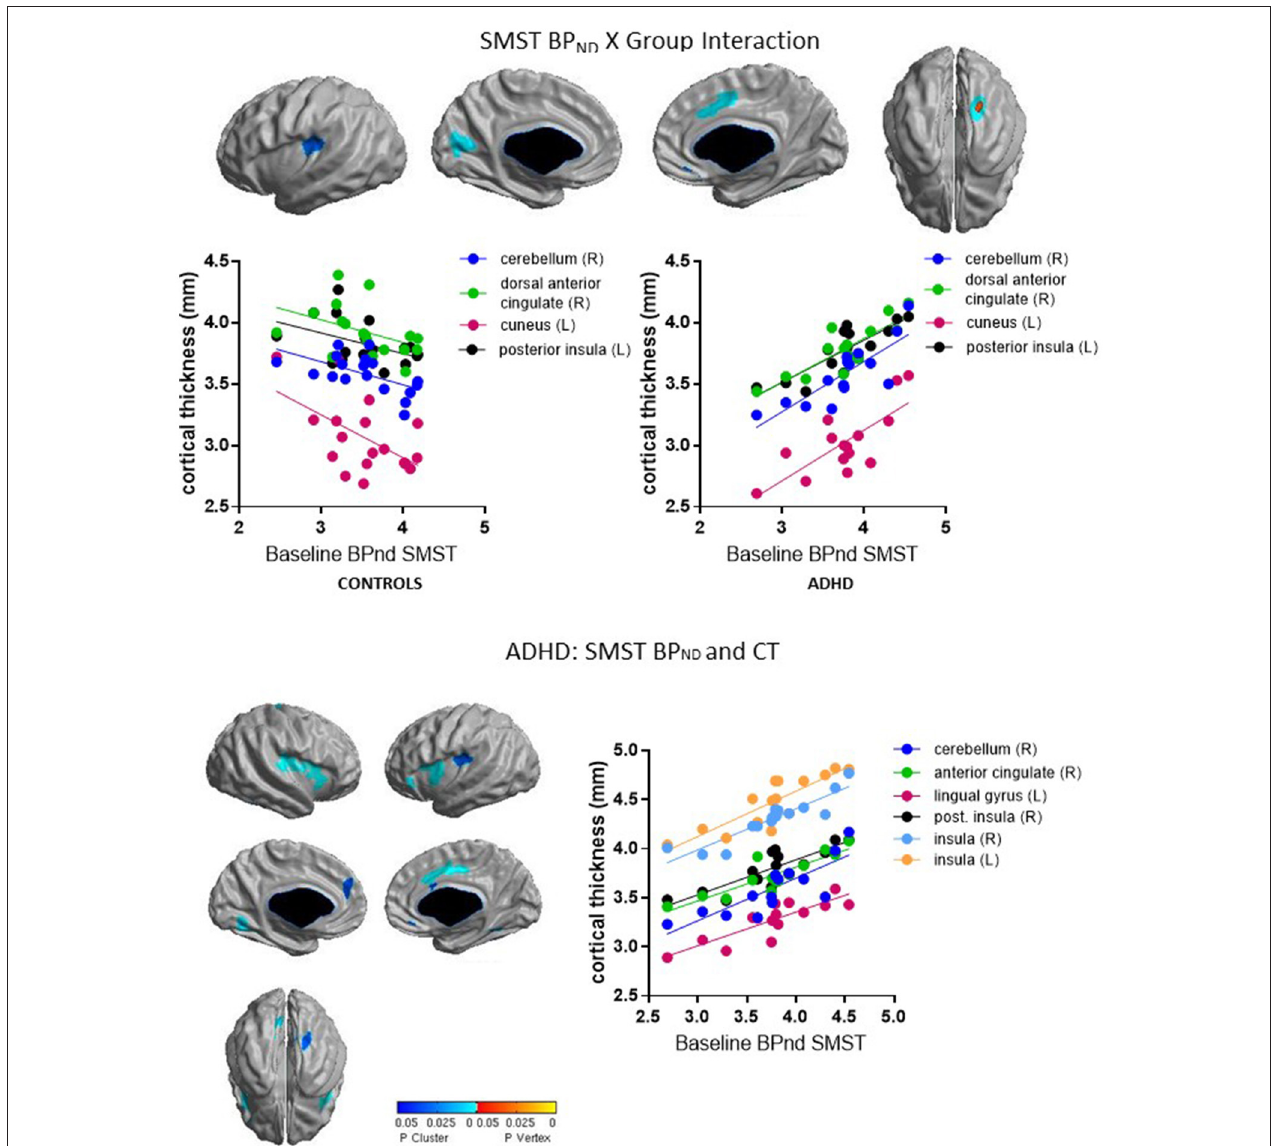
FIGURE 2 | Loci of association of baseline BP ND in SMST with cortical thickness